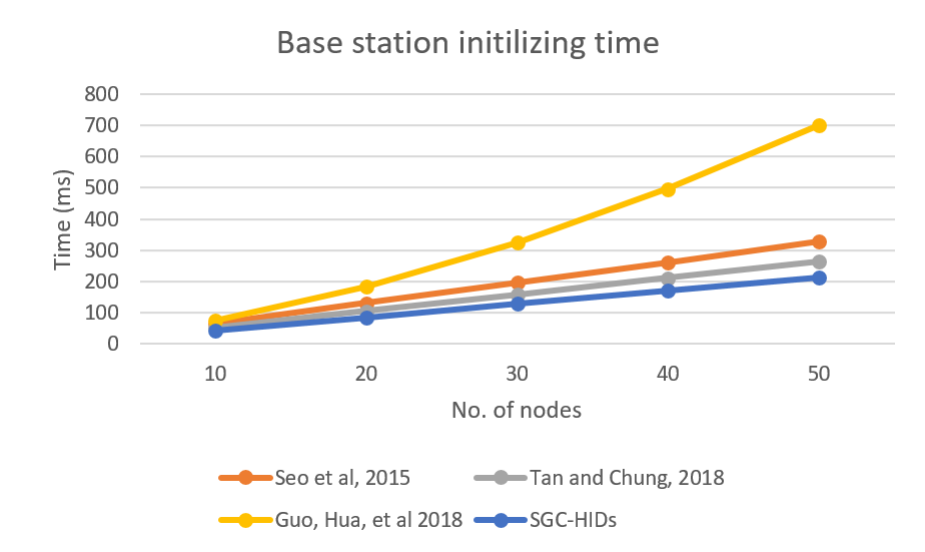
Figure 10. Base station computation time needed for initializing the